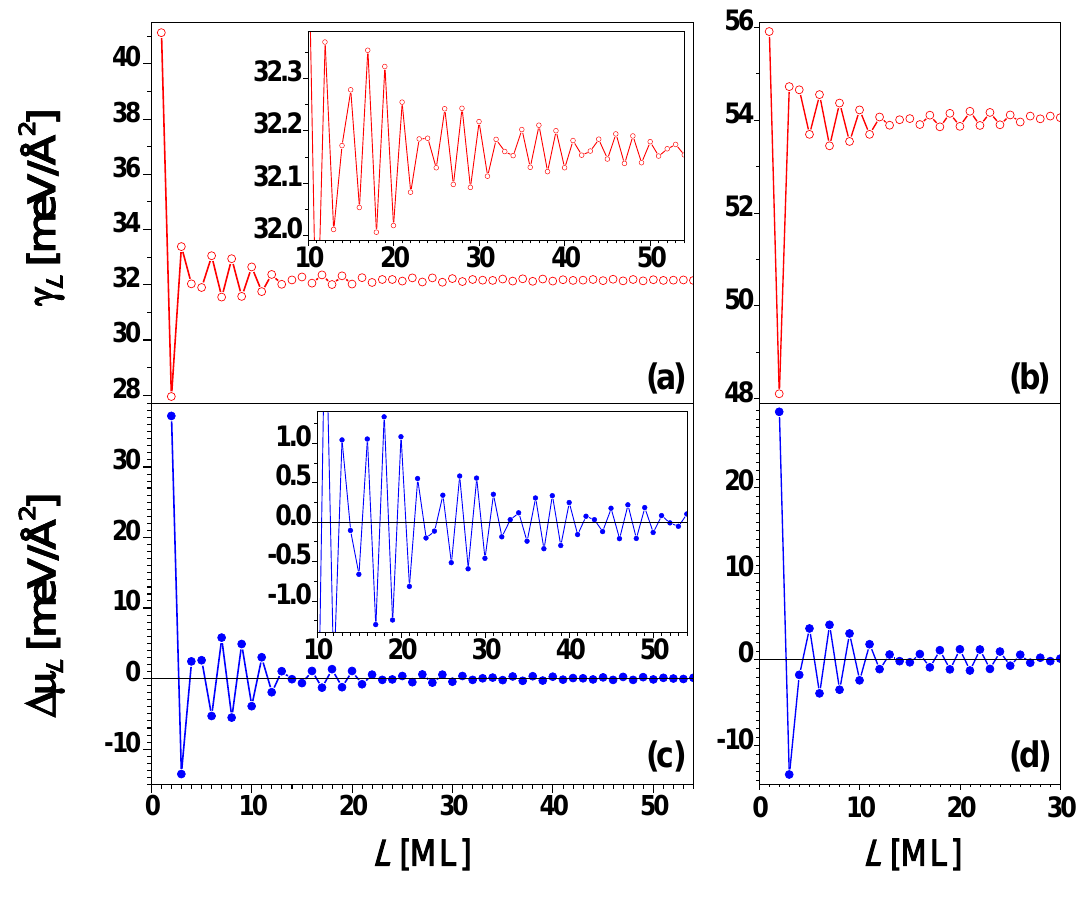
Figure 15. Surface free energy γ versus freestanding Ag(110) nanofilm thickness L from L versus L from (c) (a) EGM and (b) DFT calculations, respectively. Stability index ∆µ L EGM and (d) DFT calculations, respectively. The insets are the corresponding local enlargement. From [67] (Copyright American Physical Society